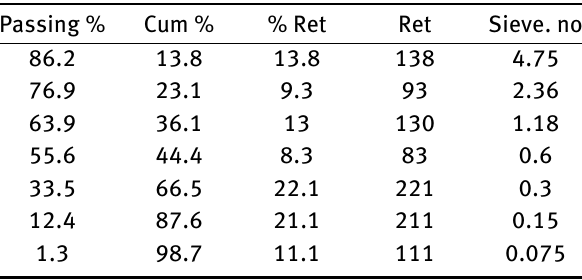
Table 1: Results of the sieve analysis of the untreated gypseous soil